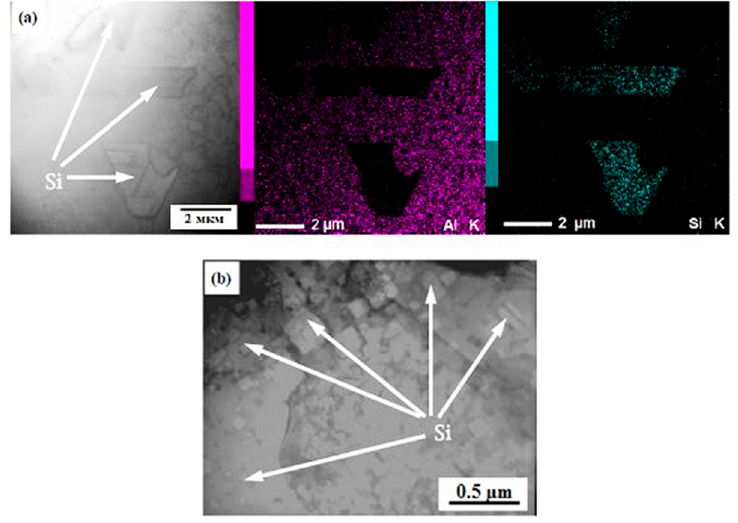
Figure 5. TEM image of the Al-7%Si alloy with 0.2 mass. % Arsal 2120: ( a ) a bright-field image and mapping of the section; ( b ) a bright-field image.